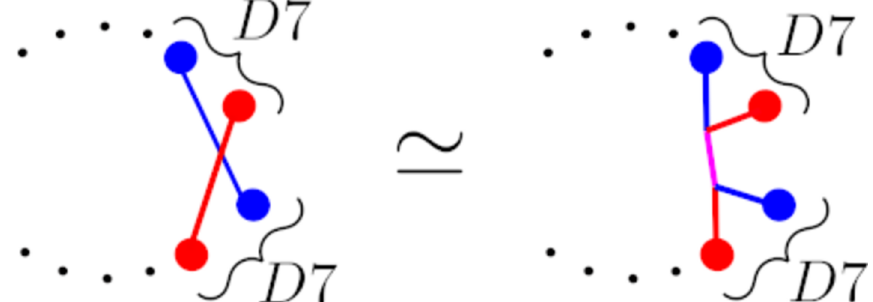
Figure 14 . Left: two D5-strings stretching between neighboring D7 branes forming BPS dyons with central charges Z d 1 and Z d 2 . Right: state with central charge Z W = Z d 1 + Z d 2 is marginally BPS in the large N limit according to eq. (4.38). Upon slightly deforming away from the origin of the Coulomb branch this state should become finitely bound due to the formation of a small F-string (purple).